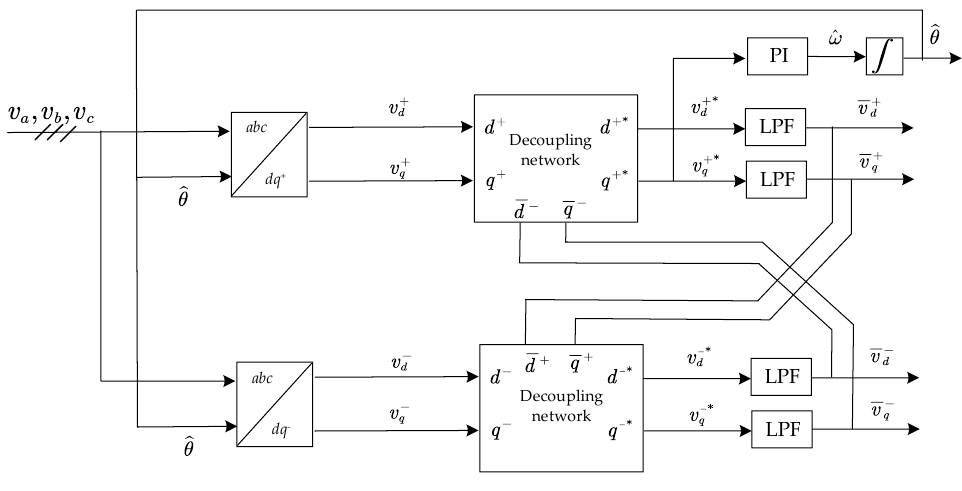
Figure 5. The structure of DDSRF-PLL.